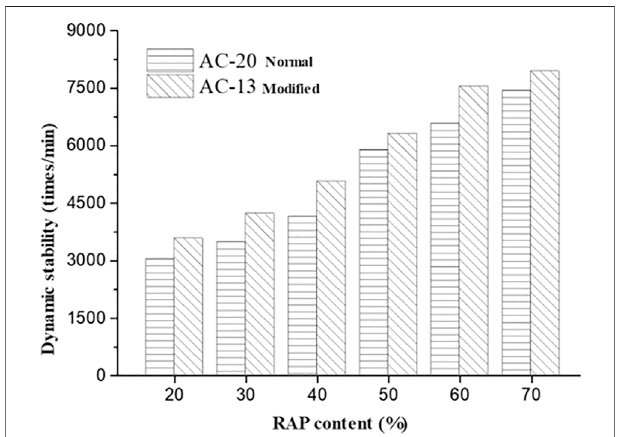
FIGURE 4 | Dynamic stability of asphalt recycled material with different RAP content.